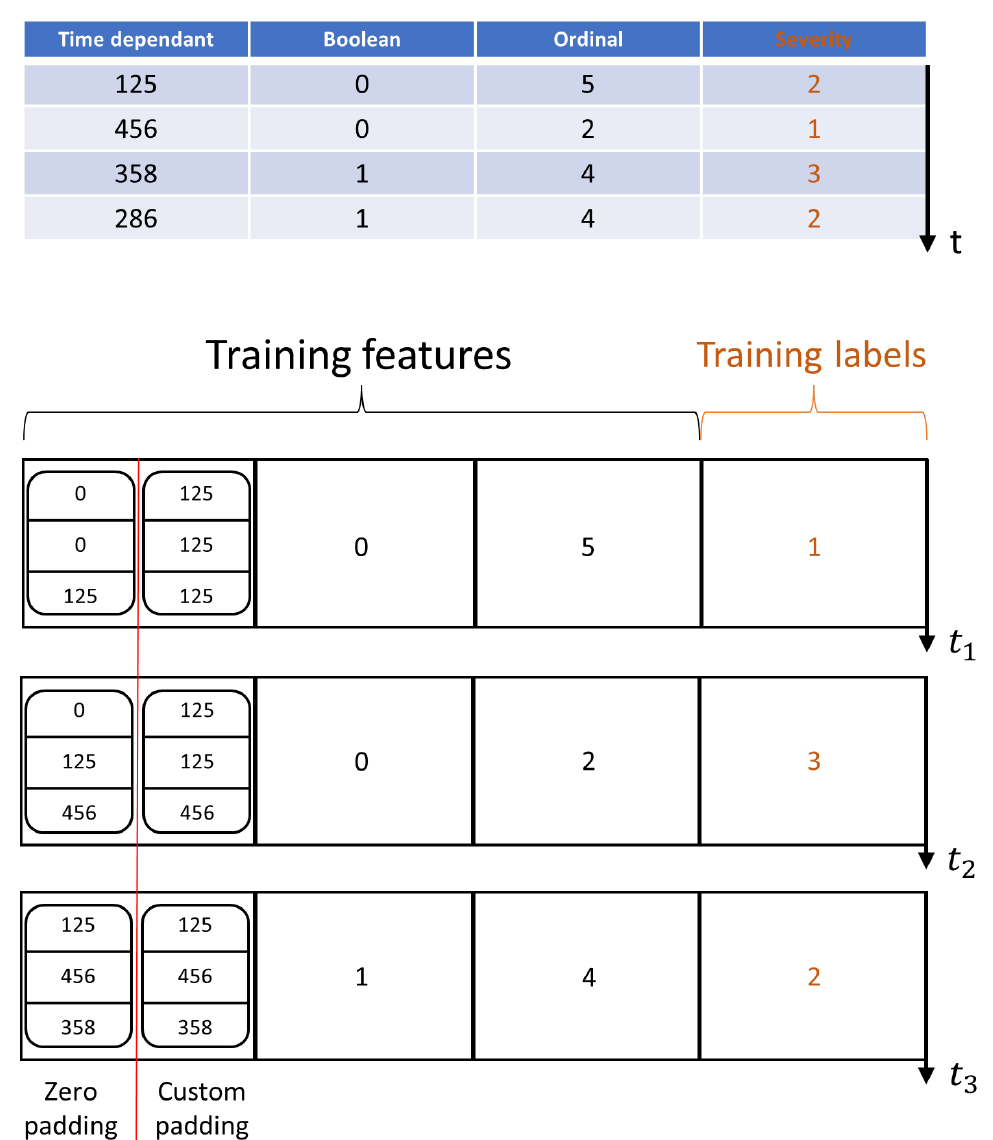
Figure 3. Visual representation of the dataset creation process. An example of data instances obtained from a single patient history. From a history of length N, N-1 data instances can be created since the most recent record cannot be associated with a future severity. Labels are represented in